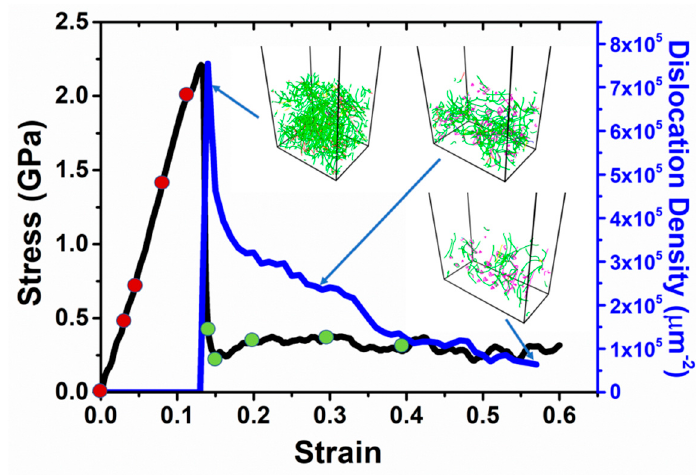
Figure 4. Tensile stress-strain curve (black) and corresponding dislocation density (blue) during the uniaxial loading along x direction. Snapshots of dislocation distribution in substrate shown in inset figures. Red and green cycles represent samples with elastic and plastic deformation, respectively, where the subsequent nanoindentions are conducted after thermal equilibration. Blue, green, pink, yellow, cyan, and red lines represent perfect, Shockley partial, stair-rod, Hirth, Frank, and other types of dislocations, respectively. The color scheme is consistent throughout this work.